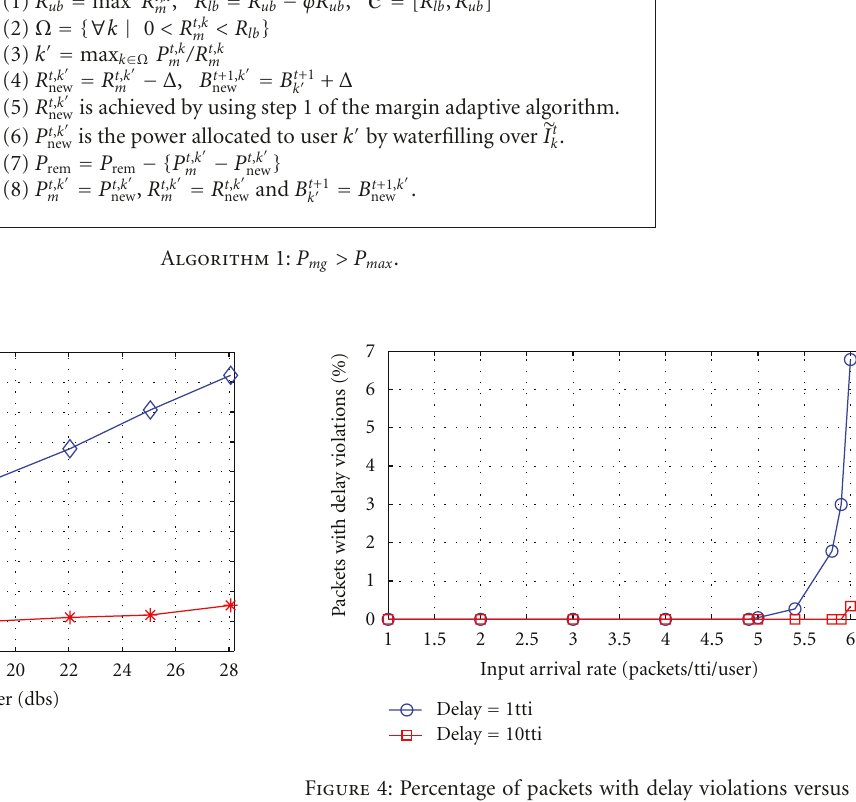
Figure 3: Total achieved rate versus P max for 10 user 24 subcarrier system. Total demanded rate = 100 bits/OFDM symbol.